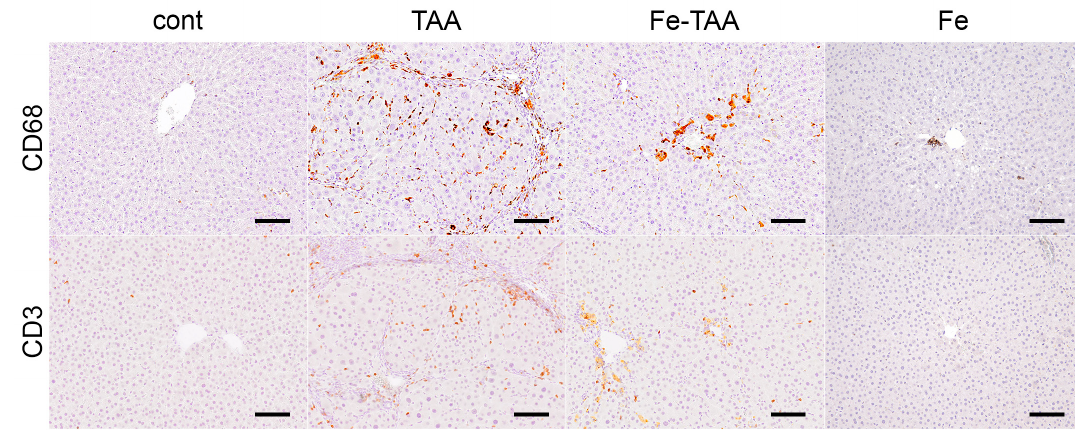
Figure 4. Immunohistochemistry for CD68 ( upper ) and CD3 ( lower ) in the liver at week 20. Note hemosiderin deposits (yellow-brown pigment, apart from immunohistochemical signals) in the Fe-TAA group. Bar: 100 µm.